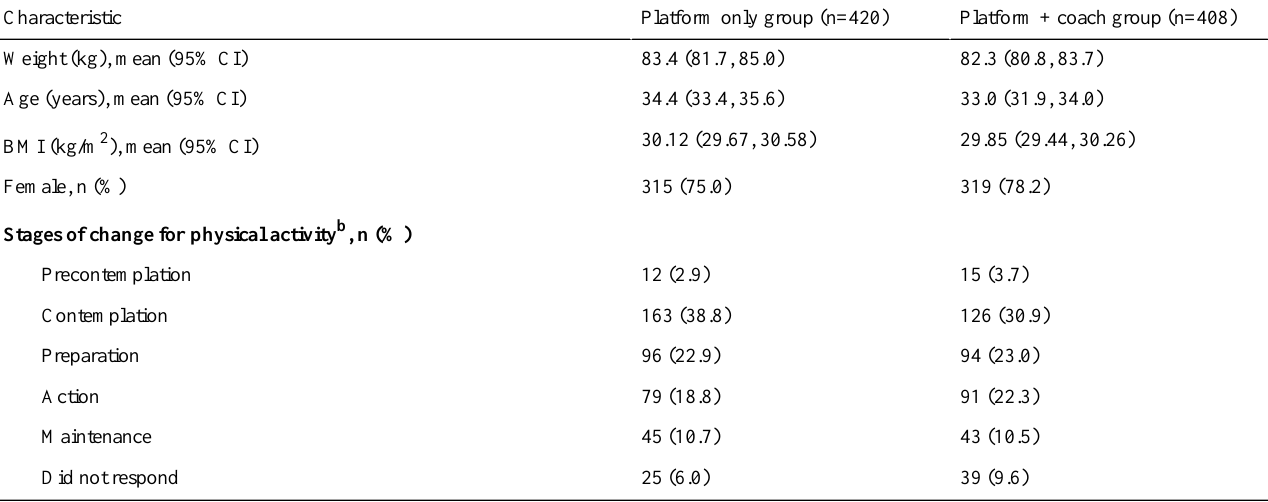
Table 2. Baseline characteristics of the groups included in the analysis a .